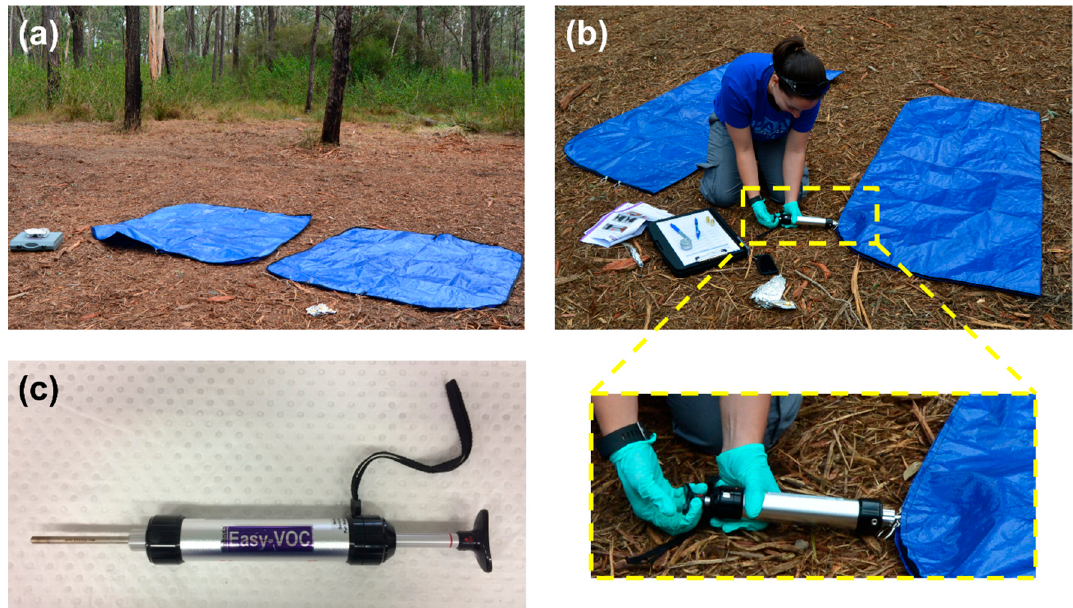
Figure 1. Collection of control headspace samples from empty body bags: ( a ) body bags open to environment prior to sample collection; ( b ) headspace sample collection through small opening in body bag closure; and ( c ) Easy-VOC™ grab-sampler with sorbent tube attached.